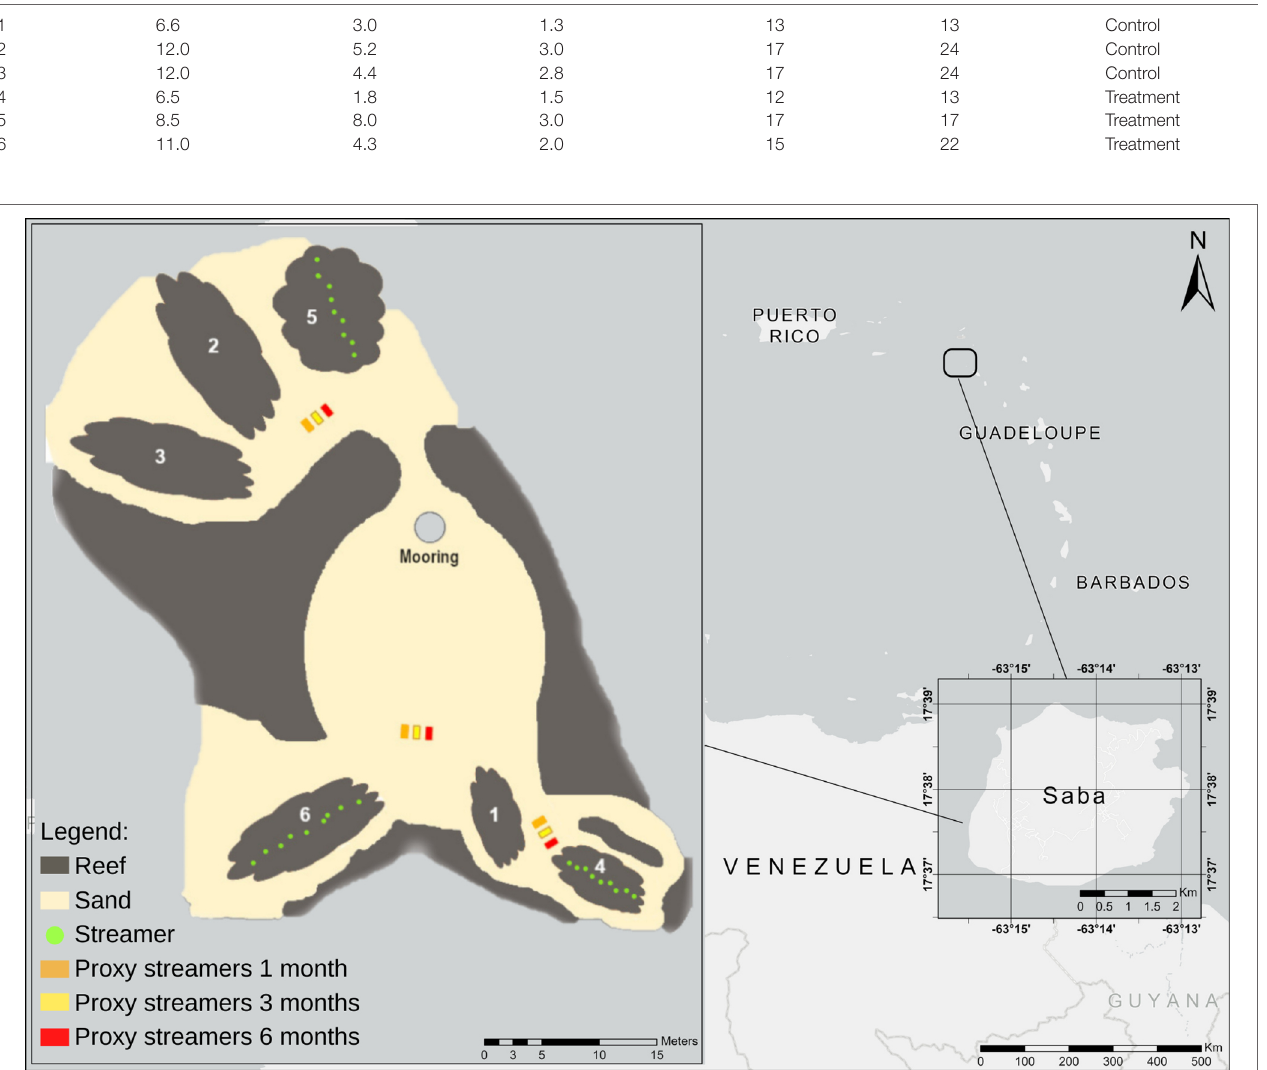
TABLE 1 | Perpendicular dimensions, depth, and experimental surface area of the patch reefs. Reef number Longest dimension (m)